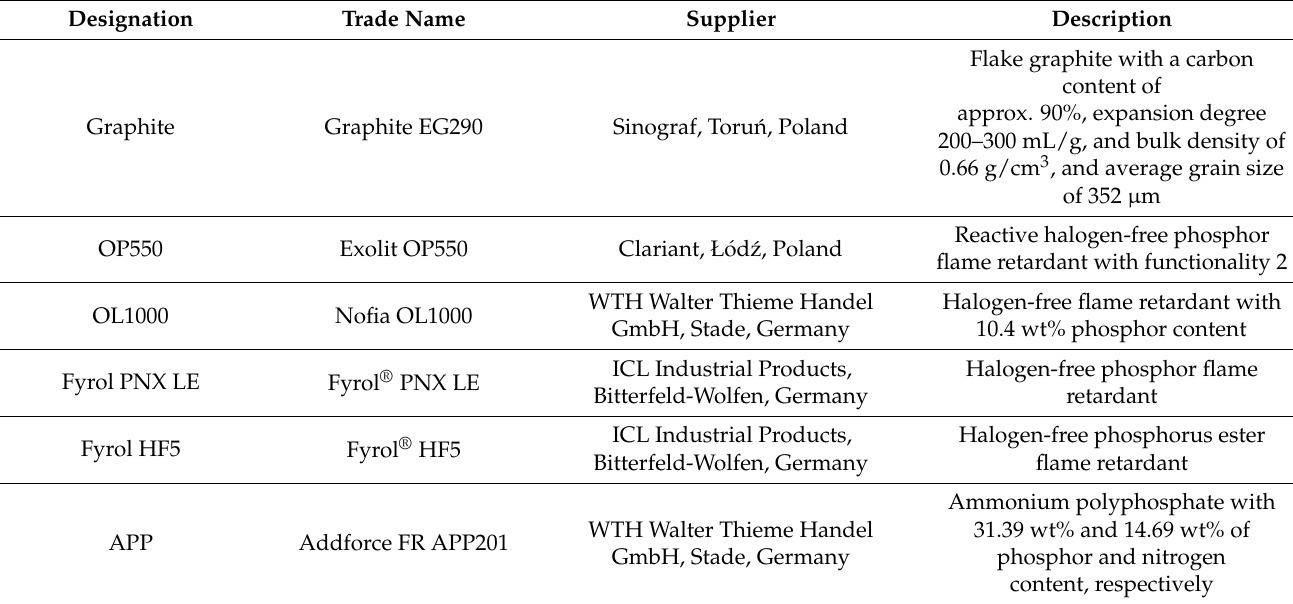
Table 1. Characteristics of the